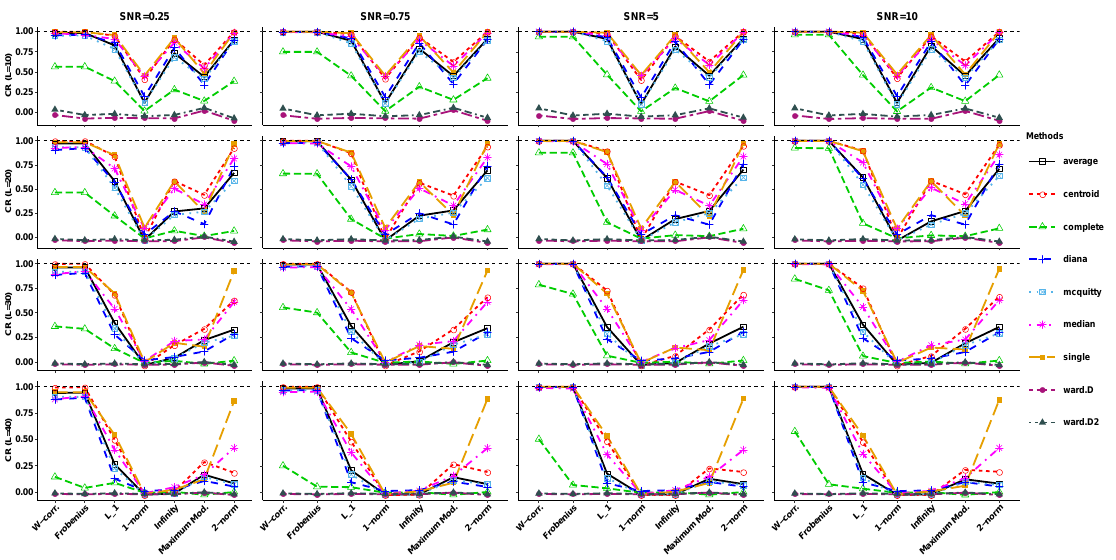
Figure 2. Corrected Rand (CR) index for the exponential series (case a).